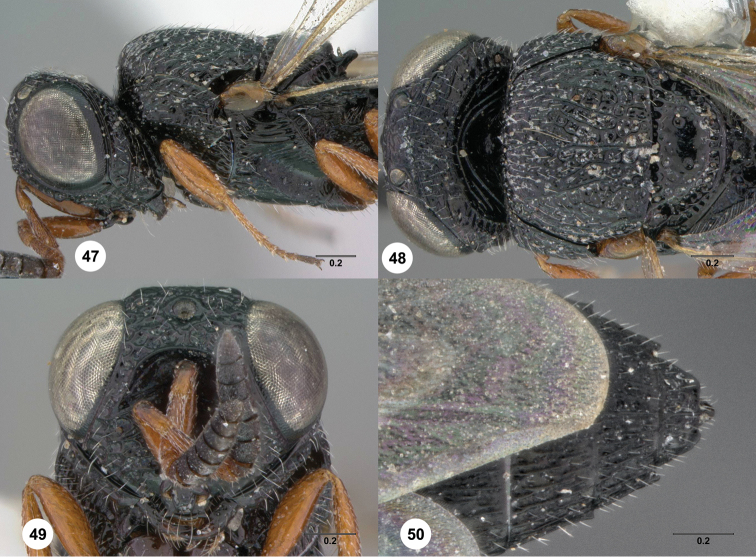
Oxyscelio clupei sp. n., paratype female (OSUC 359628) 47 Head and mesosoma, lateral view 48 Head and mesosoma, dorsal view 49 Head, anterior view 50 Metasoma, dorsal view. Morphbank36